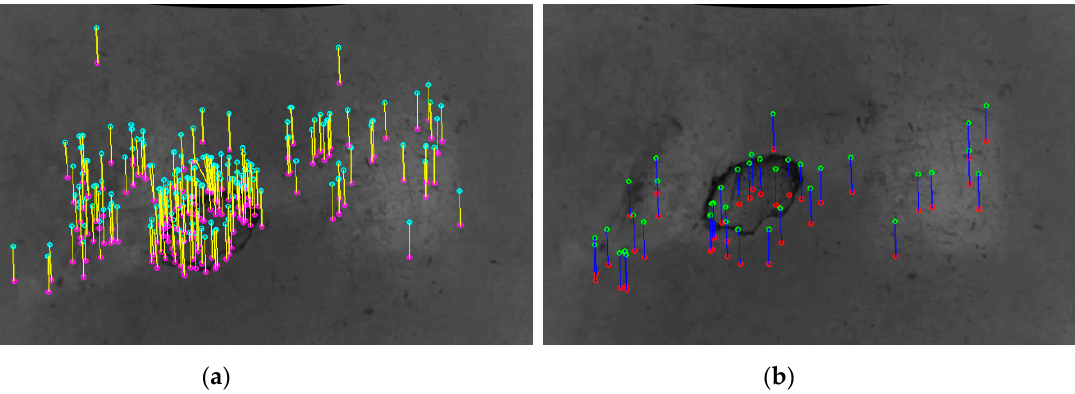
Figure 8. ( a ) Rejected and ( b ) good correspondences by applying the geometric invariance check approach. The parameter t is set to 0.85 and a cardinality C equal to three is considered.